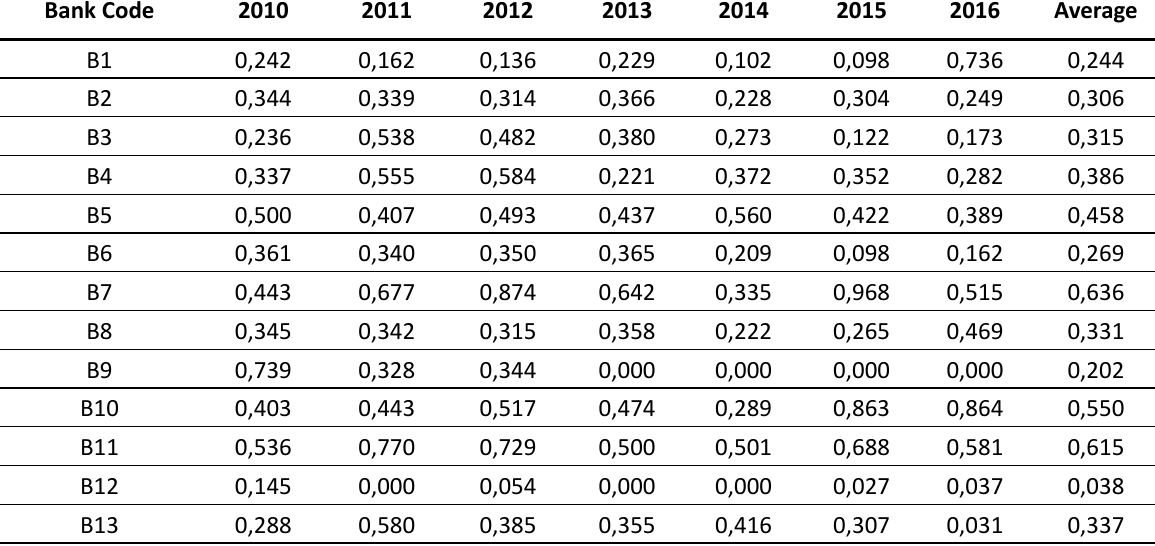
Table 1: Profit Efficiency with Bank Intermediation Approach (PIB) Year 2010 - 2016 Bank